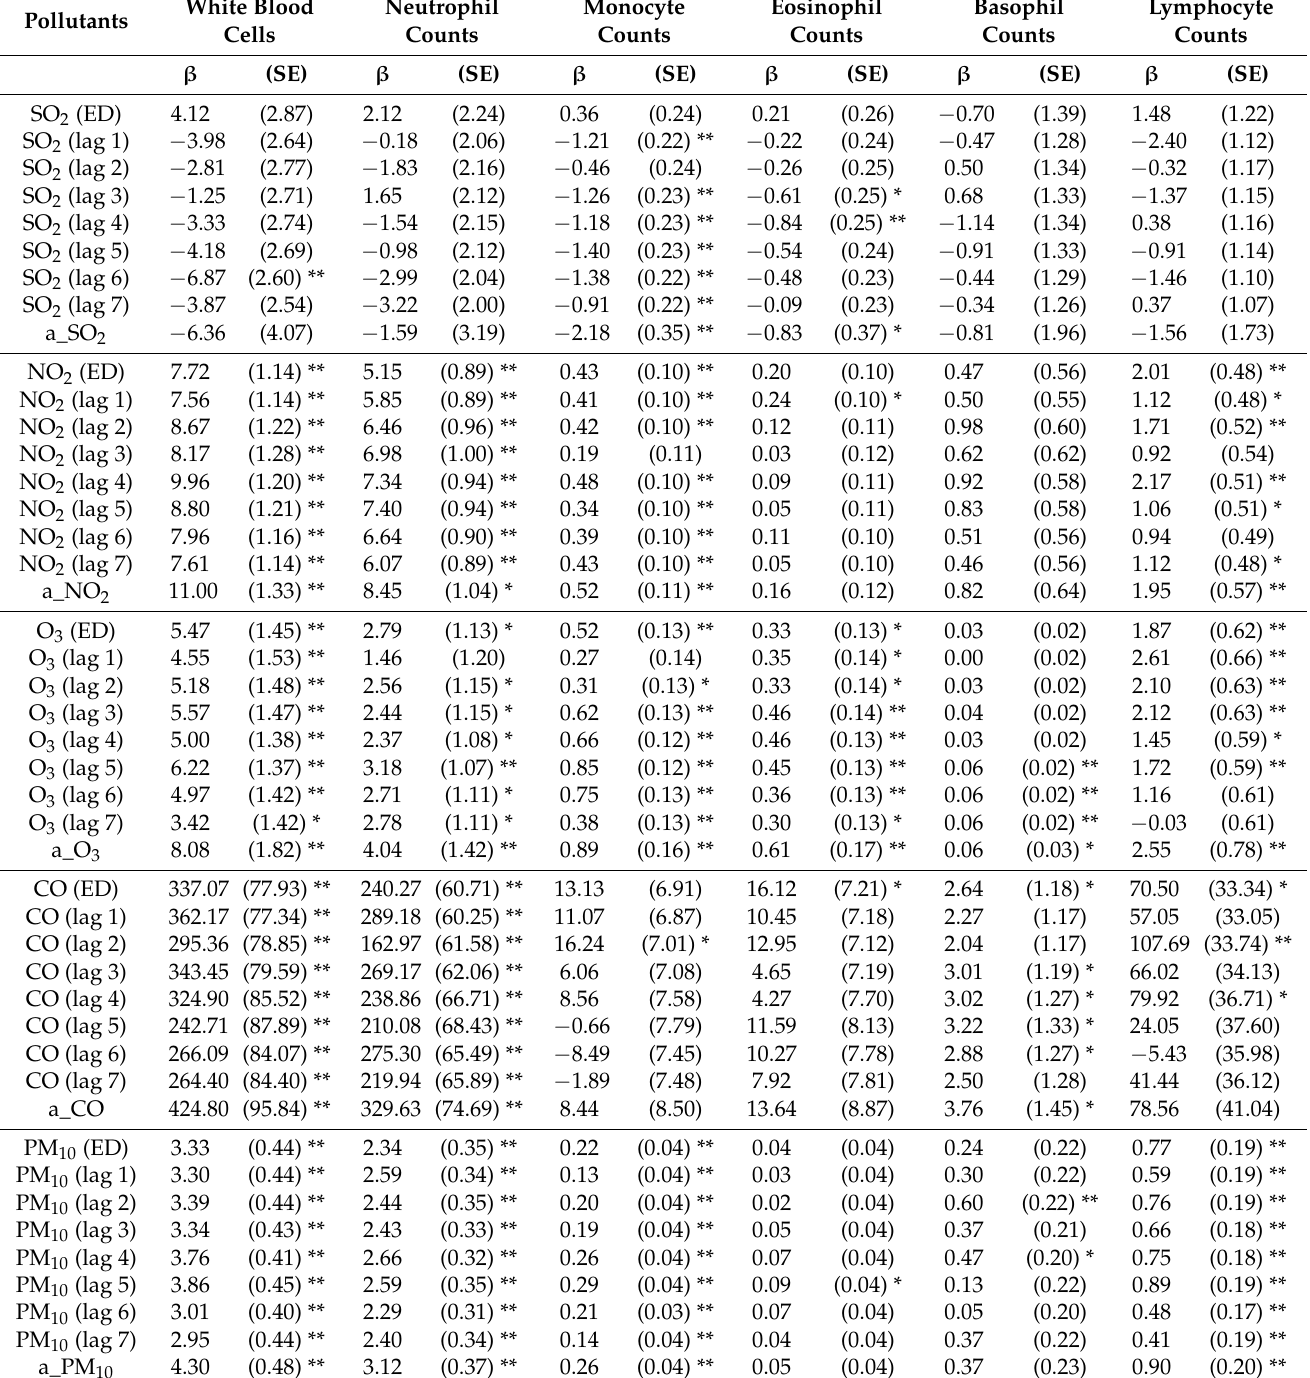
Table 3. Single-pollutant model: the associations between common air pollutants and white blood cells after adjusting gender, age, BMI, smoking, drinking, and betel quid chewing.